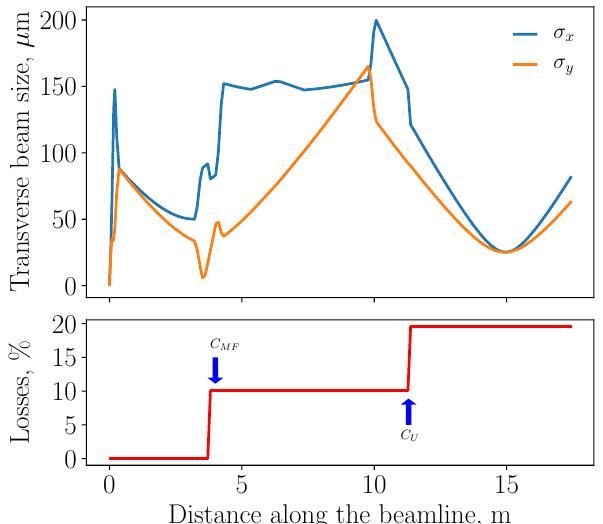
Figure 2. Simulated electron beam horizontal and vertical envelopes (top) and beam losses (bottom) along the beamline. Arrows on the bottom plot show the position of the momentum filter collimator ( C MF ) and collimator before the undulator entrance ( C U ). Parameters: electron energy is 350 MeV, decompressor bending angle is 0.35 deg, initial bunch charge is 45 pC. The center of the single-unit undulator is located at 15 m from the